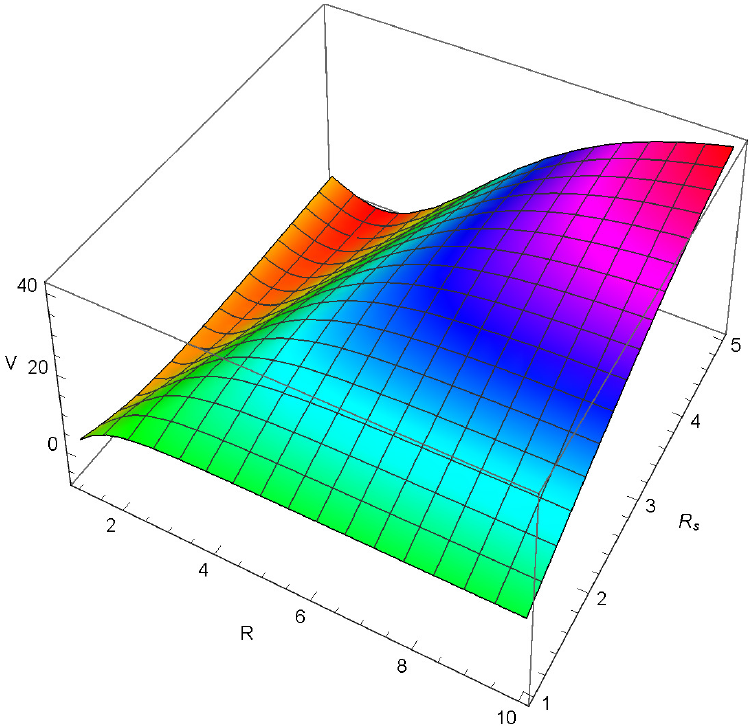
Figure 29. Solution of V ( φ 2 ) for n = 2. The evolution of V ( φ 2 ) is obtained using Equations (32) and (45).